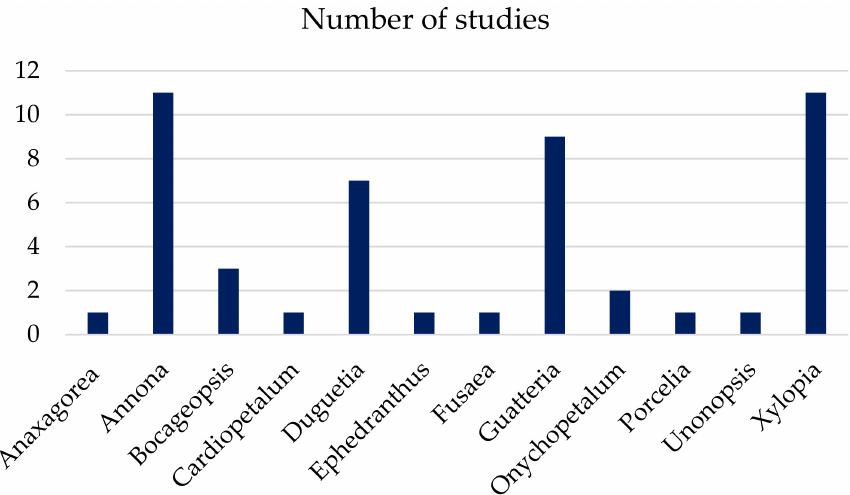
Figure 1. Distribution of studies with essential oils according to the genus of Annonaceae occurring in Brazil from 2011 to 2021.